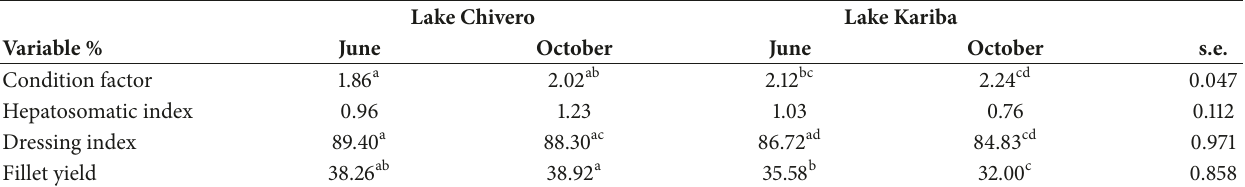
Table 2: Carcass quality of Oreochromis niloticus from Lake Kariba and Lake Chivero.